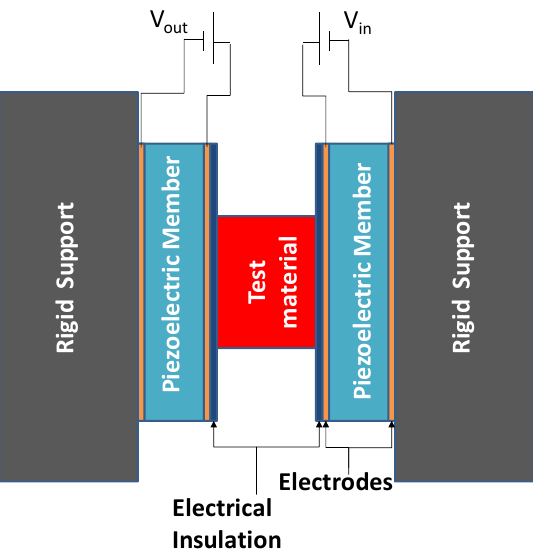
Figure 1. The dual piezoelectric-actuator-sensor